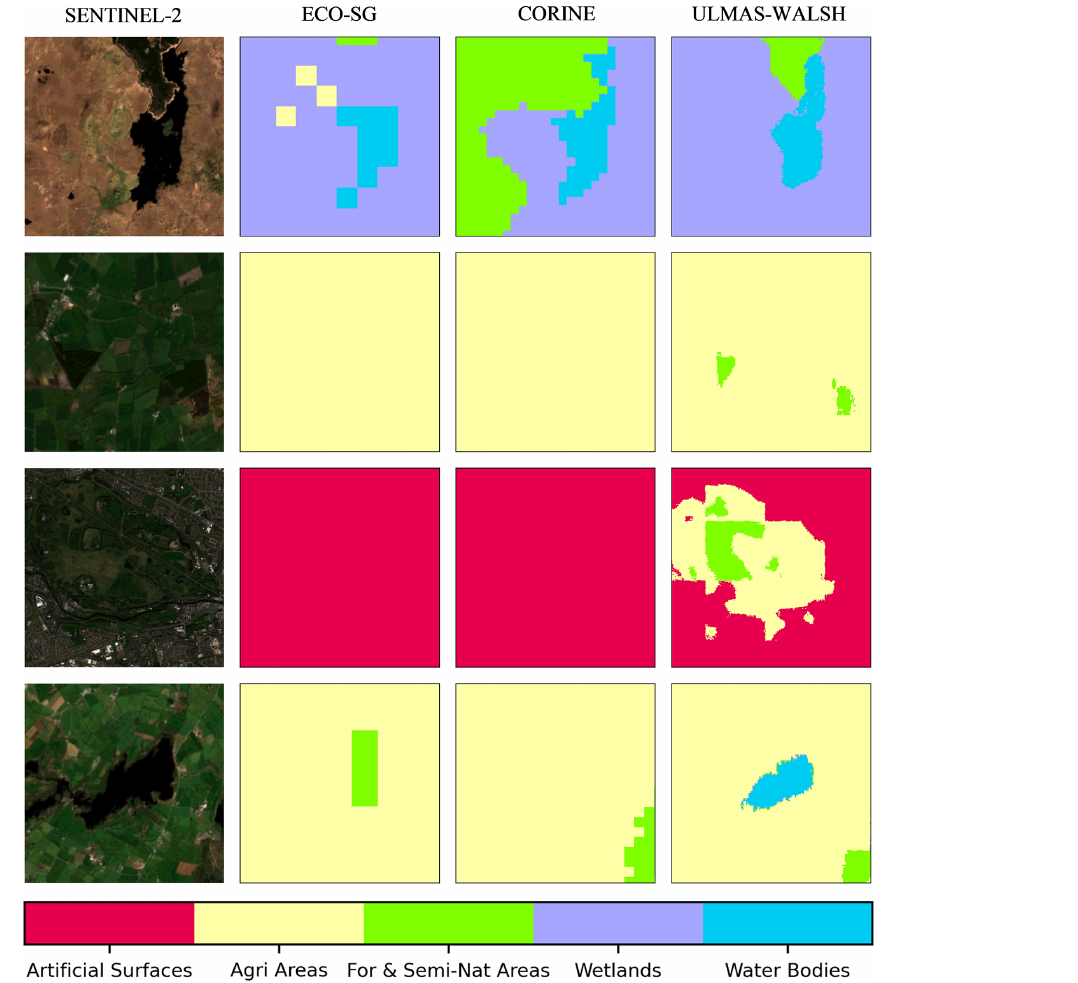
Figure 7. Satellite image segments and the corresponding ECO-SG, CORINE and UW cover maps for these images. Row 1 represents a bog in County Galway in the West of Ireland (53.30, − 9 . 34). Row 2 represents an area in County Tipperary in the midlands (52.72, − 7 . 75). Row 3 represents the Phoenix park and its surrounds in County Dublin in the East (53.35, − 6 . 33) Row 4 represents a lake in County Galway in the west (53.10, − 8 . 87). The fully labelled ECO-SG and ESA-CCI land-cover maps for these satellite images can be found in Appendix C. The satellite images were produced from ESA remote sensing